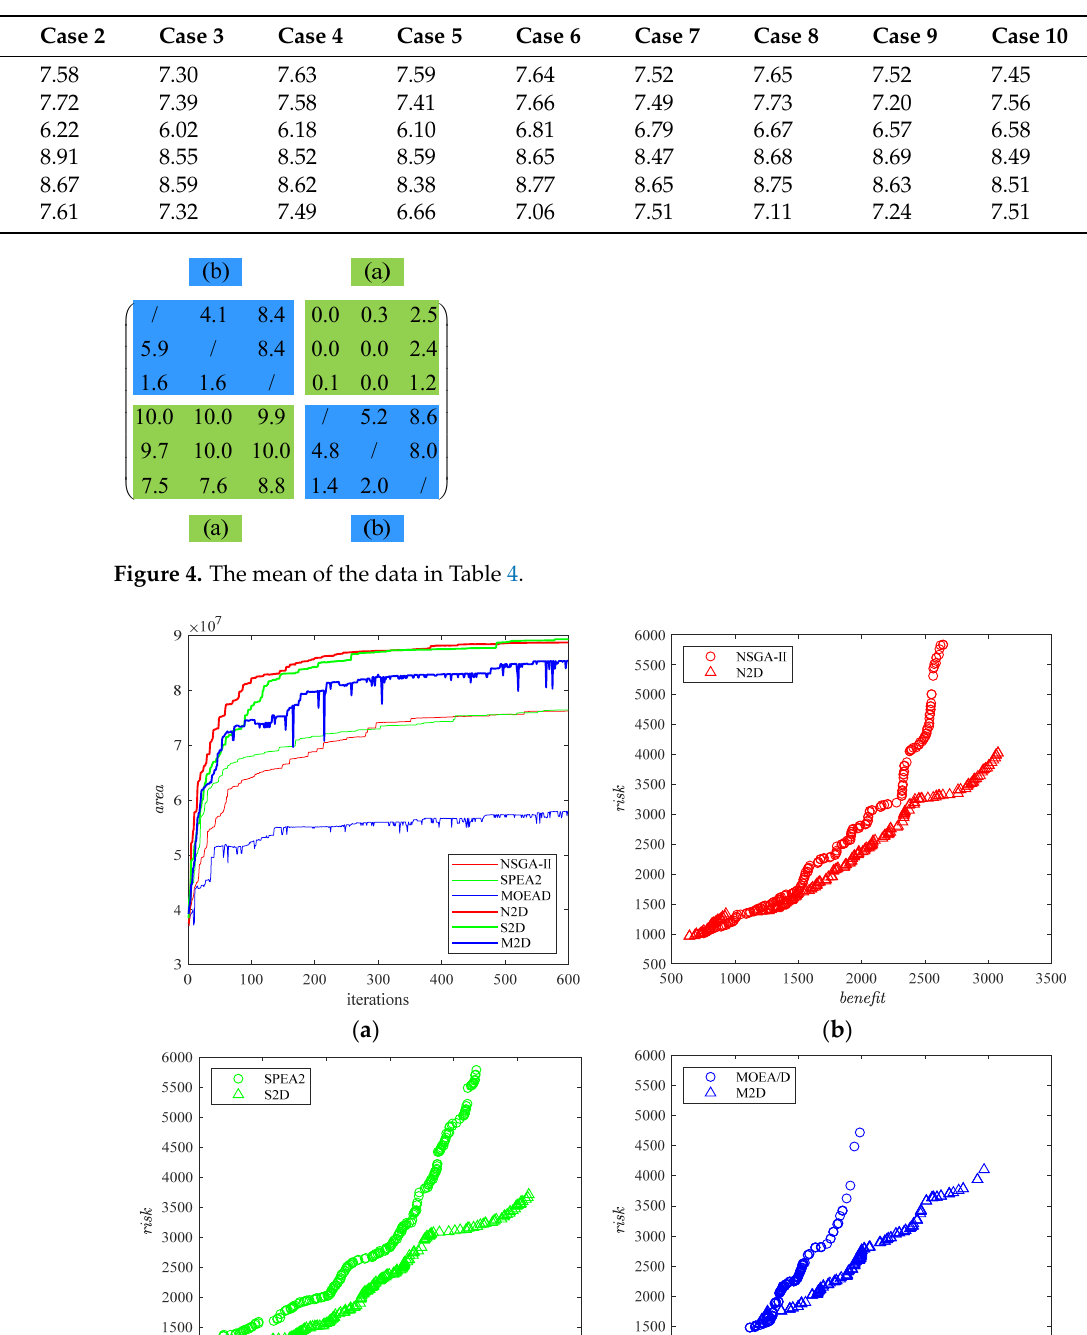
Table 7. The calculation results of area (Order of magnitude × 10 7 ).